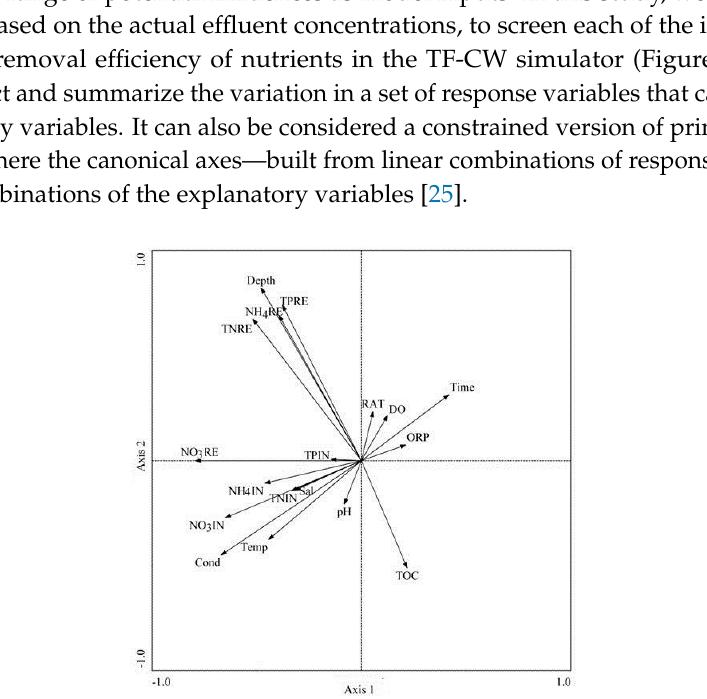
Figure 6. Backpropagation (BP) neural network algorithm process.